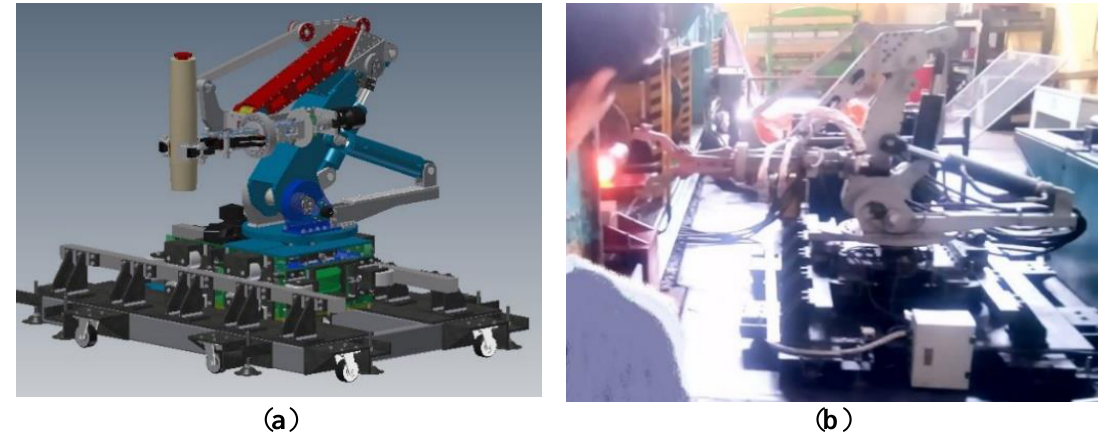
Figure 5. The forging robot: ( a ) The 3D design, and ( b ): The robot prototype.